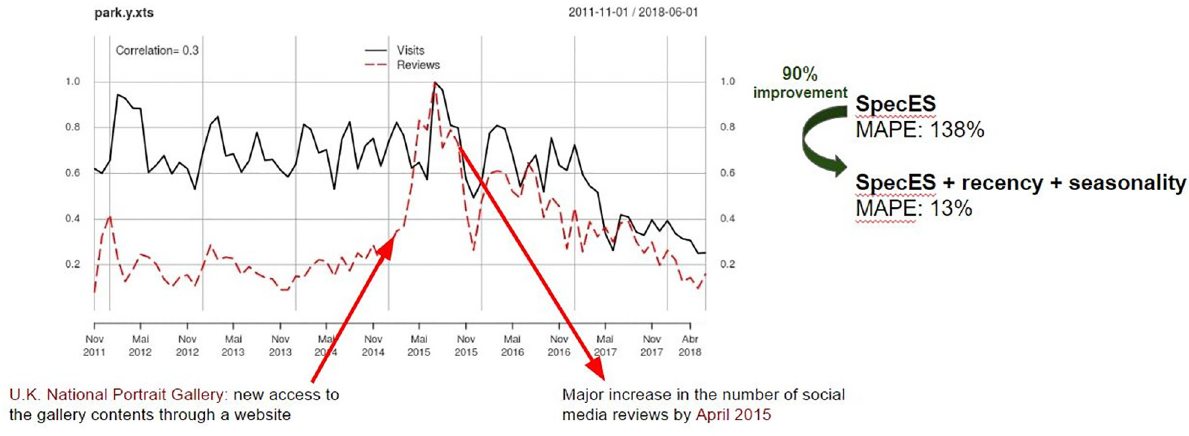
Fig 6. Temporal evolution of number of visits and social media comments in National Portrait Gallery in U.K.—highly more accurate prediction model using specialized model with all recency and seasonality features.